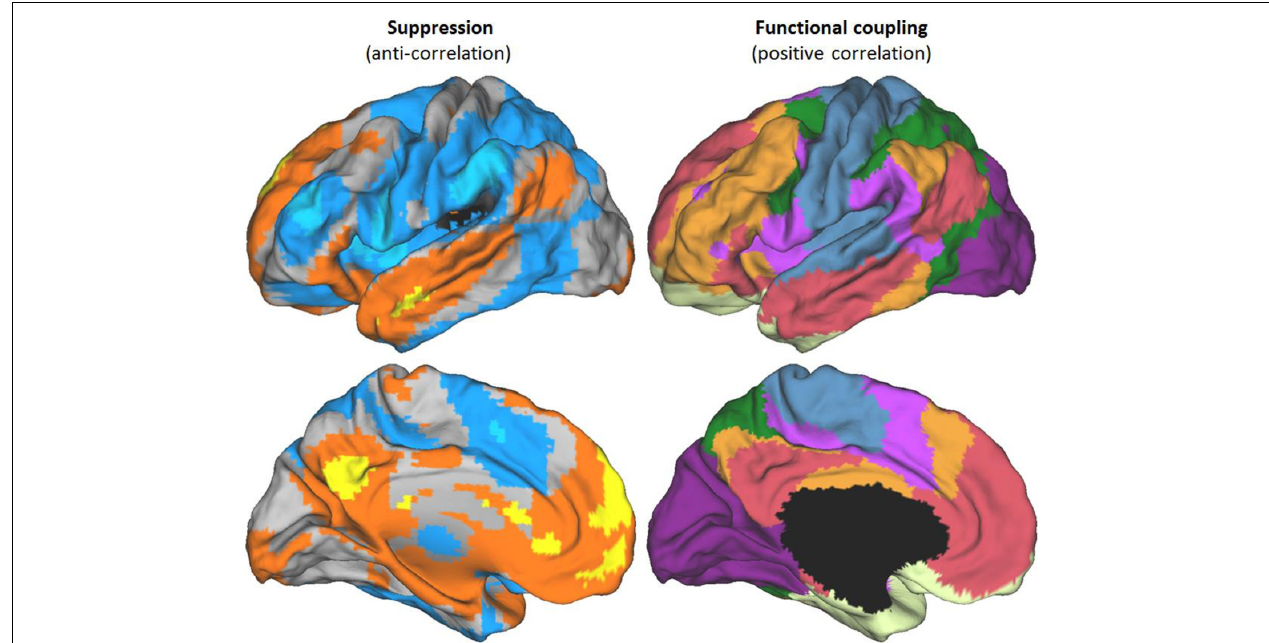
FIGURE 1 | Different criteria for defining brain networks. Functional networks shown on the left hemisphere of the PALS atlas ( top – lateral view above, bottom – medial view). Left panels show anti-correlated networks derived from resting state data. The TPN is shown in blue, the DMN in orange/yellow. Darker colors correspond to anti-correlated networks using a global (whole brain) regressor, brighter colors without a